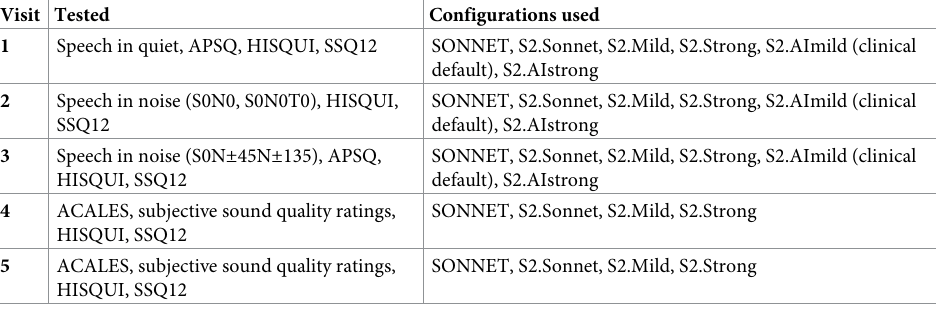
Table 3. Testing schedule with fitting configurations. Visit Tested Configurations